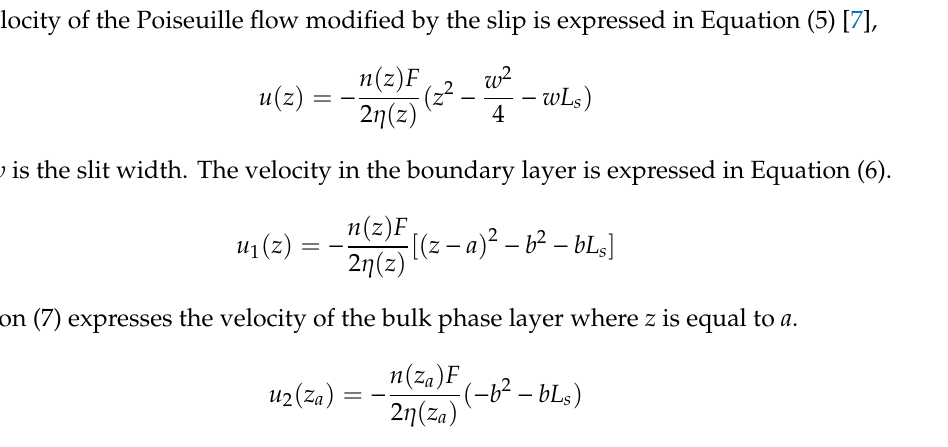
Figure 8. The separate fitting of the fluid velocity profile. F = 30 × 10 − 4 kcal / mol. (The dashed red line is the fitting in the free layer with the same velocity where z = 12.5Å. The dashed blue line is the separation between the boundary and bulk phase layers. Half of the velocity profile is in the FSL).